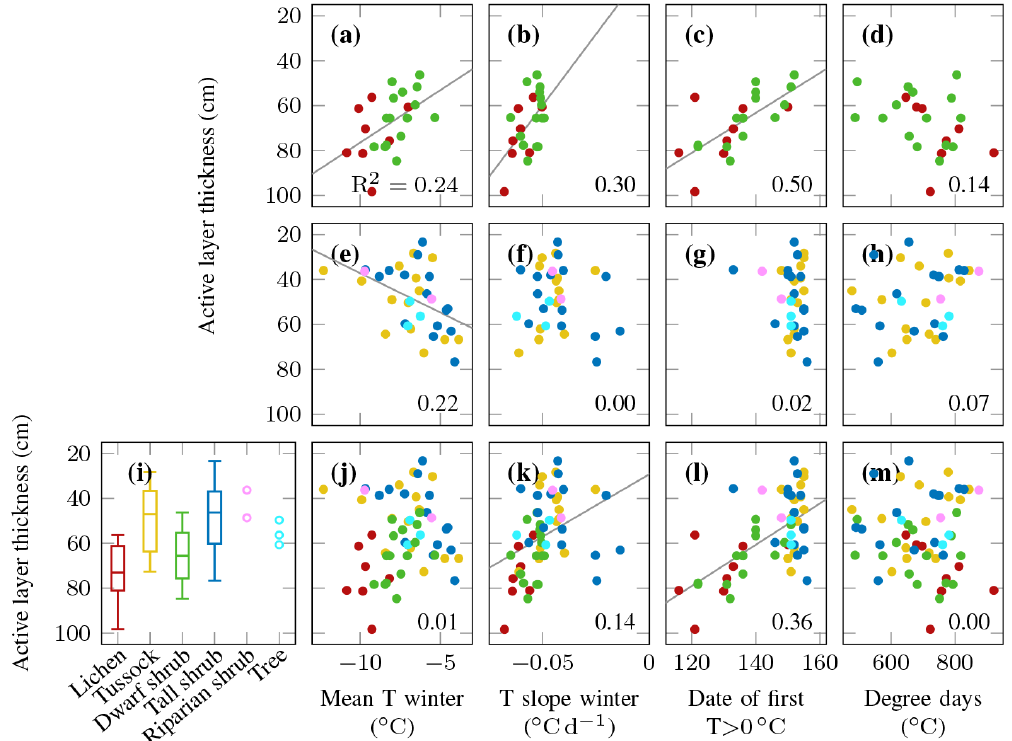
Figure 10. The relationship between active layer thickness at the end of August 2018 and (i) vegetation type; (a, e, j) mean topsoil winter temperature; (b, f, k) rate of topsoil cooling in winter; (c, g, l) day of the year when the topsoil warms above 0 ◦ C; (d, h, m) cumulative sum of positive degree days until the end of August of the same year; top row: lichen and dwarf shrub tundra; middle row: tussock, tall shrub, riparian shrub, and tree; bottom row: all vegetation types; the numbers indicate the Pearson’s correlation coefficient R 2 ; the thin grey lines are regression lines of significant ( p < 0 . 05)